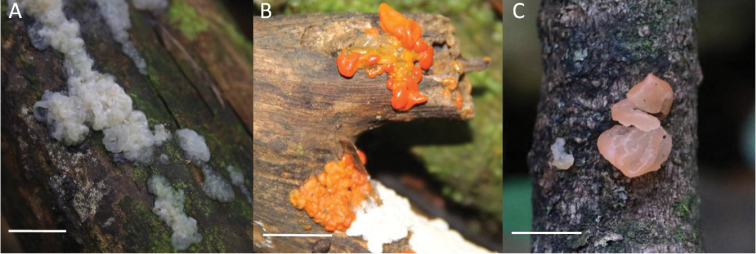
Macromorphology of Tremella basidiomata. AT.cheejeniiBT.erythrina C T.salmonea. Scale bars: 1 cm.